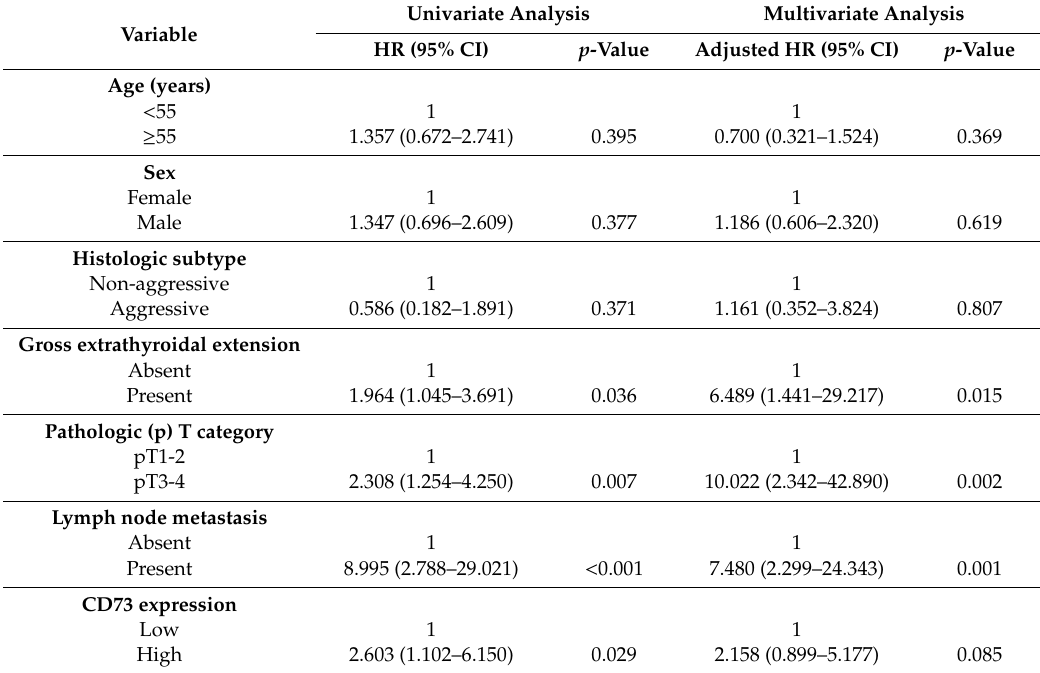
Table 2. Univariate and multivariate Cox regression analysis of prognostic variables for recurrence-free survival in 502 patients with papillary thyroid carcinoma.